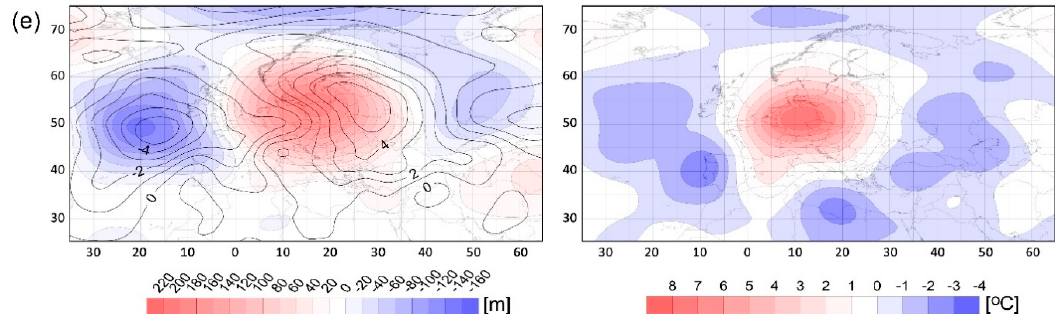
Figure 9. Mean anomalies of z300 hPa (colour shades) and SLP (black lines) (left column) and mean anomalies of T850 (colour shades) (right column) on days preceding the commencement of waves of hot nights over Central Europe and on their first day (( a ): 9 days before the commencement of the waves; ( b ): 7 days before; ( c ): 5 days before; ( d ): 3 days before; ( e ): 1 day of waves of hot nights) for type 1.